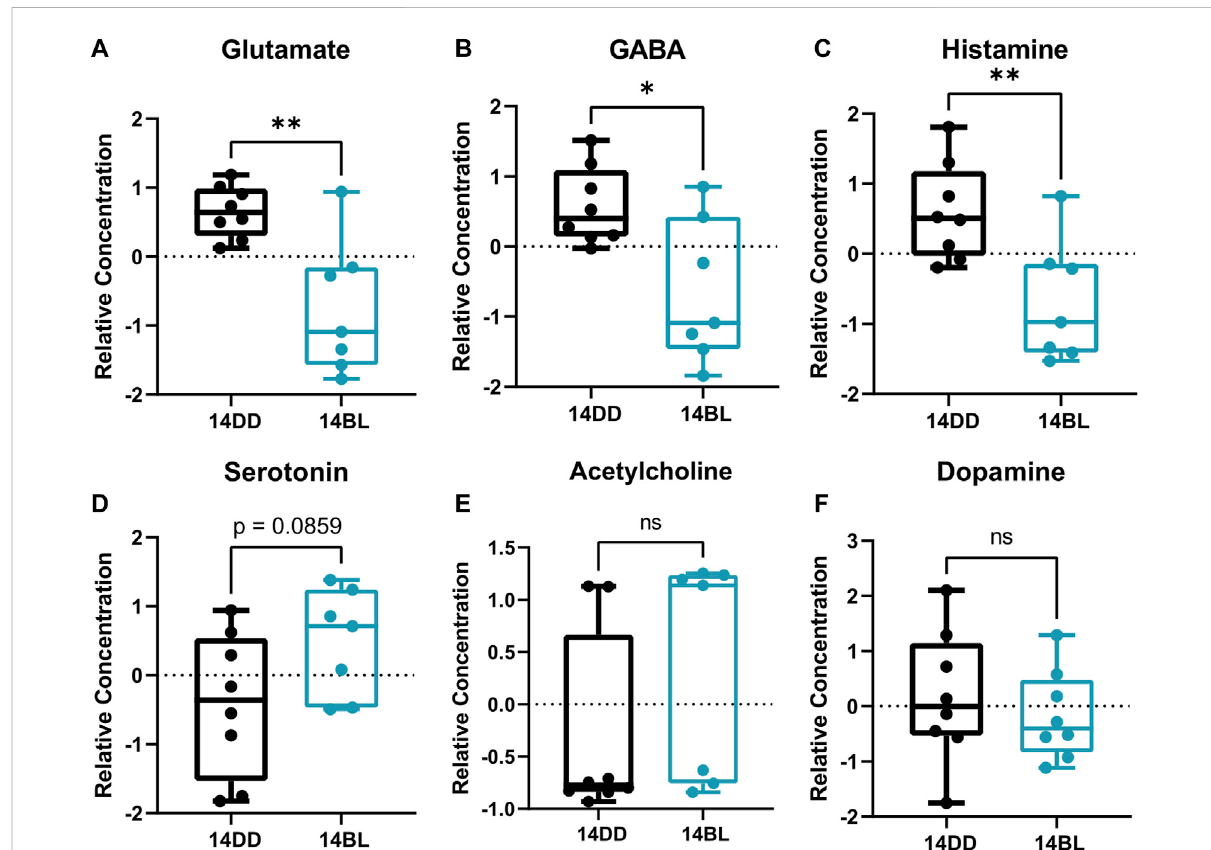
FIGURE 6 Some neurotransmitters are signi fi cantly reduced after 14 days of chronic BL. (A – F) Relative concentration of Glutamate, GABA, and Histamine are signi fi cantly lower after 14 days of chronic BL but others are not altered. Lines in box plot represent max, upper quartile, median, lower quartile, and min from top to bottom. Statistical analysis by unpaired t -test ( pp p < 0.01, p p < 0.05, ns p >